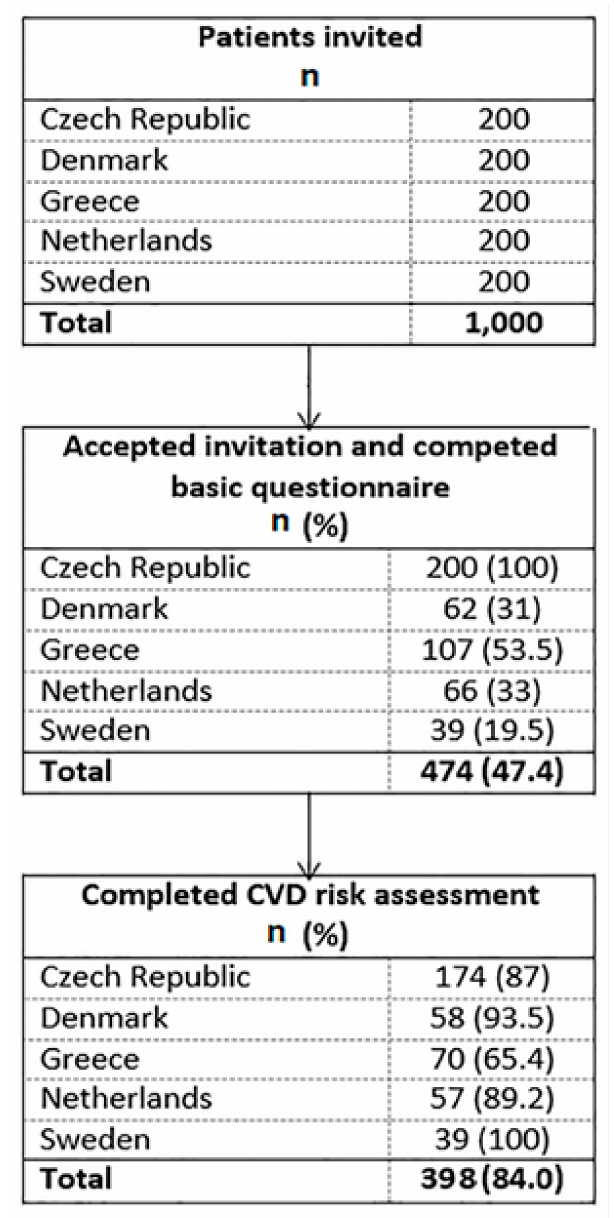
Figure 1. Study flow chart in the five European primary care settings.